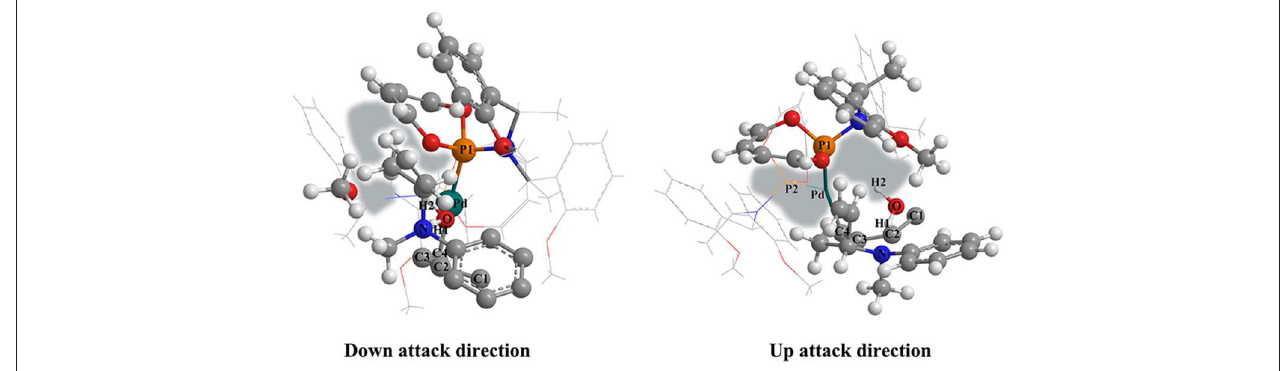
FIGURE 8 | Visualizing the structure of the TSIV-Ib ′ -R state (left picture) and the TSIV-Ib ′ -S state (right picture). The space around the butenyl of the N -butenyl- N -methylaniline has been painted in light gray.